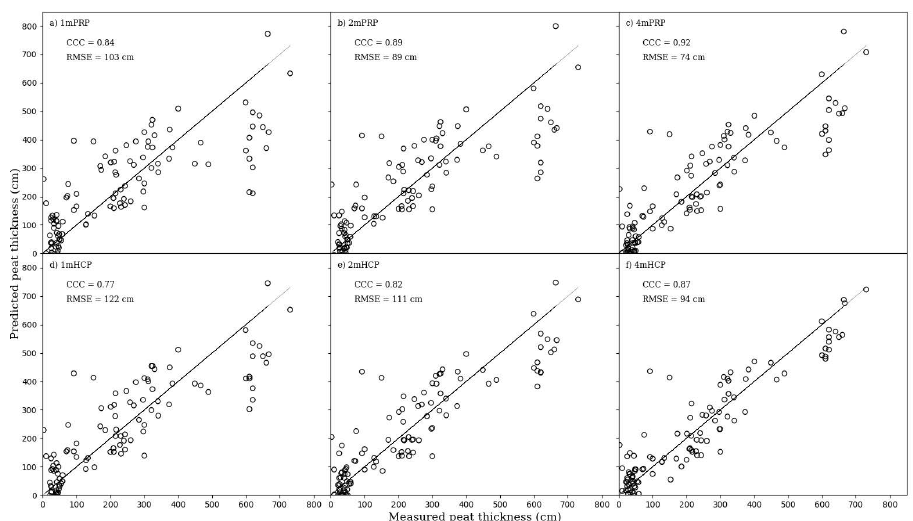
Figure 7. Measured vs. predicted peat thickness (cm) using leave-one-out cross validation (LOOCV) for EC a collected from the six different coil configurations of a DUALEM-421S instrument: ( a ) 1mPRP, ( b ) 2mPRP, ( c ) 4mPRP, ( d ) 1mHCP, ( e ) 2mHCP and ( f ) 4mHCP (1:1 identity line represented on each